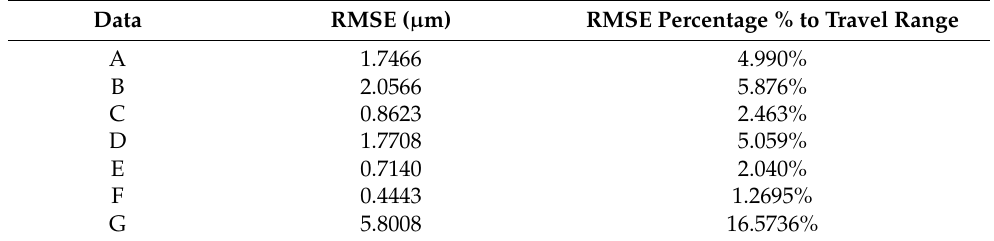
Table 1. Tracking performance of the considered piezoelectric actuator without hysteresis compensation.